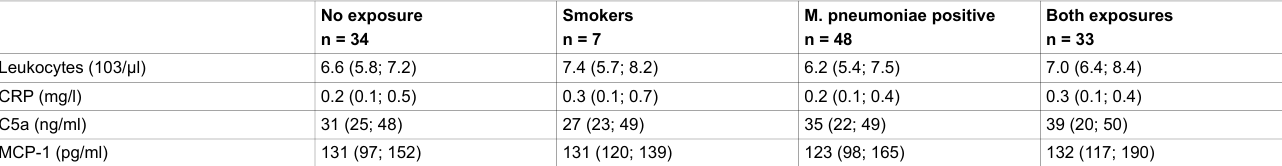
Table 3 Circulating levels of inflammatory biomarkers in groups of differently exposed individuals. Median values (25, 75 percentiles) are given. No significant differences were